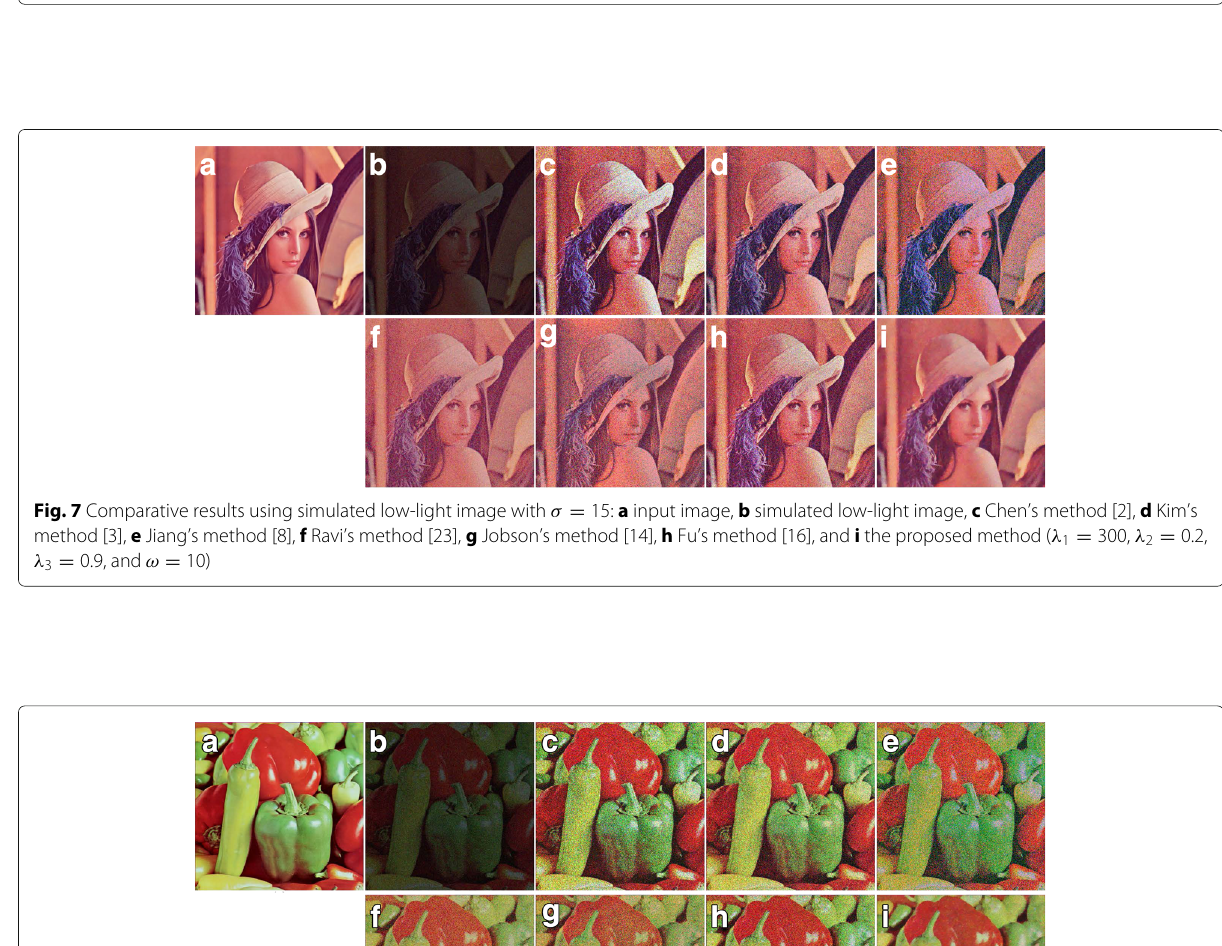
Fig. 6 Comparative results using simulated low-light image with σ = 10: a input image, b simulated low-light image, c Chen’s method [2], d Kim’s method [3], e Jiang’s method [8], f Ravi’s method [23], g Jobson’s method [14], h Fu’s method [16], and i the proposed method ( λ 1 = 300, = 0.15, λ = 0.9, and ω = 10) λ 2 3